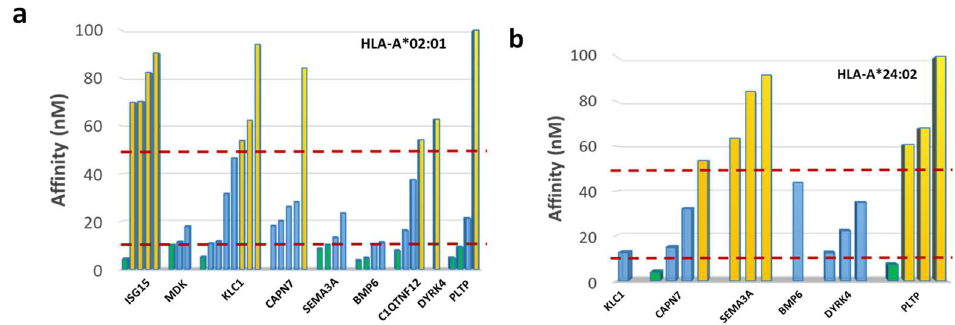
Figure 4. Number of epitopes with affinity > 50 nM, 10 nM < affinity < 50 nM and affinity < 10 nM for ( a ) HLA-A*02:01 and ( b )